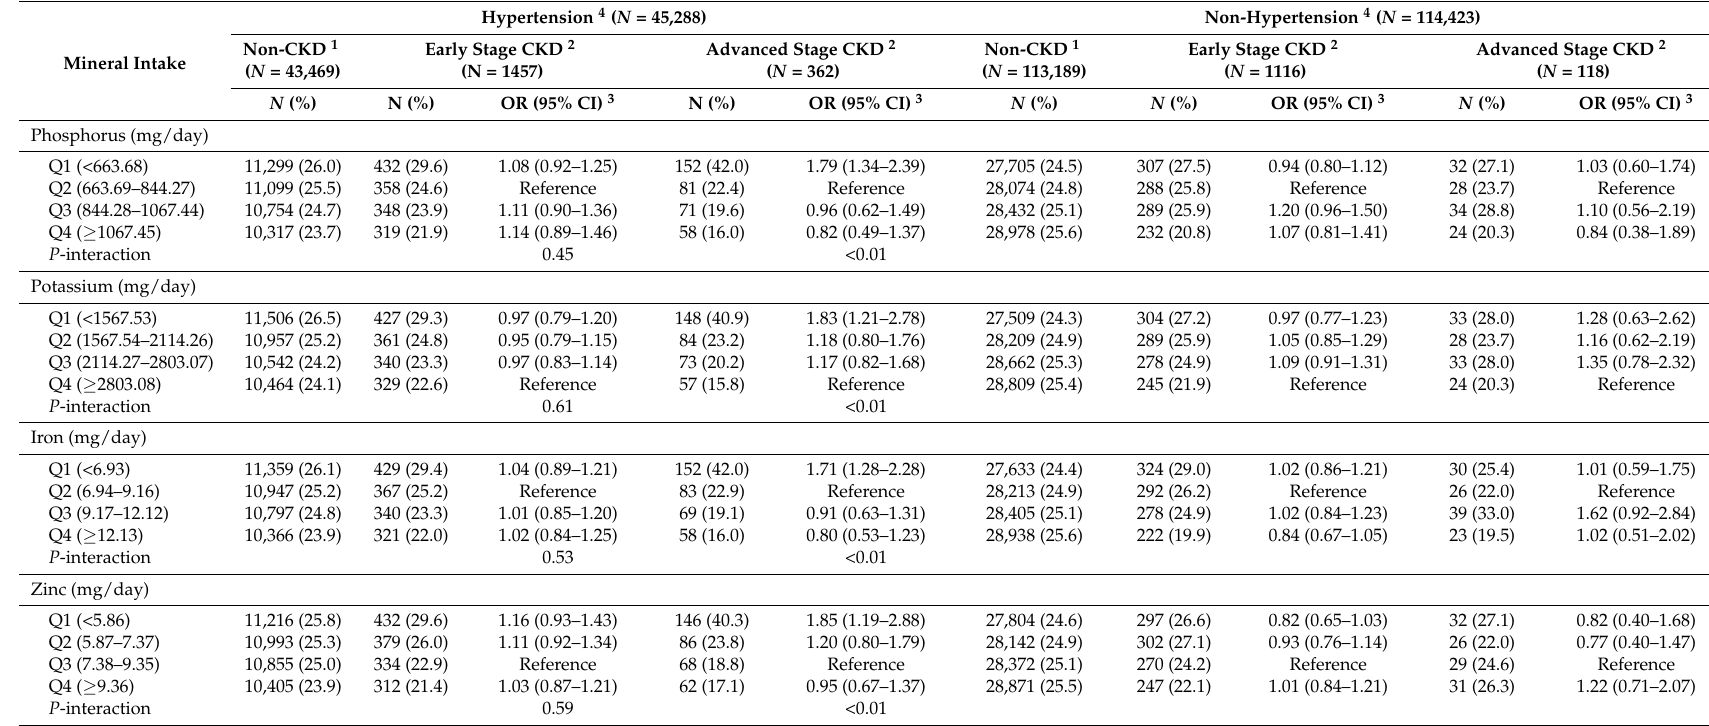
Table 3. Association between dietary mineral intake and CKD stages stratified by hypertension status in the Health Examinees (HEXA) study of the Korea Genome and Epidemiologic Study (KoGES),